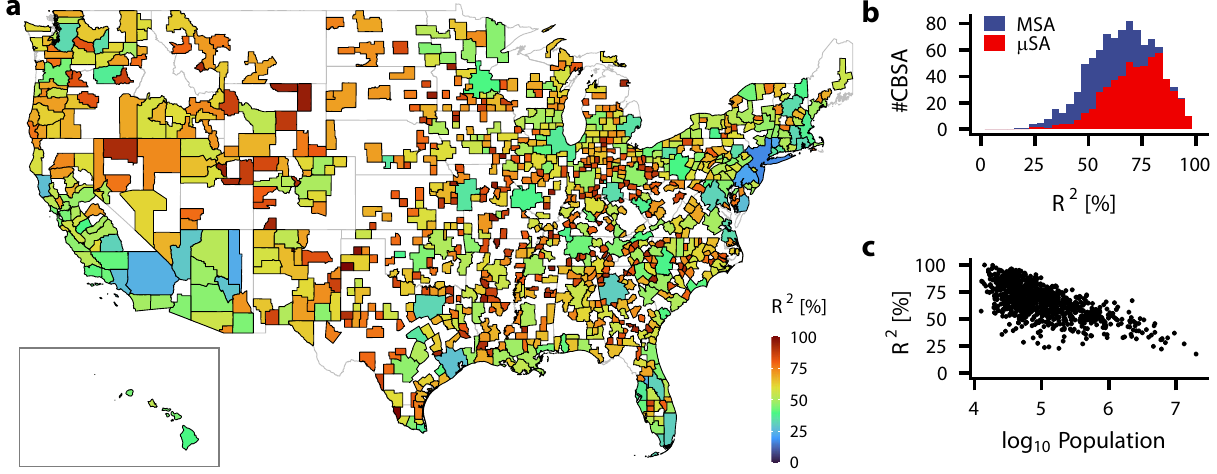
2 2 Figure 5. Percentage of gradient component R in human flow. ( a ) Percentage R in home-work trips for each Core-based statistical area (CBSA) in 2018. The inset shows the CBSAs in Hawaii. ( b ) Histogram of percentage R 2 . CBSAs are classified into metropolitan statistical areas (MSAs) and micropolitan statistical areas ( µ SAs). ( c ) 2 Percentage R is plotted against the population of the